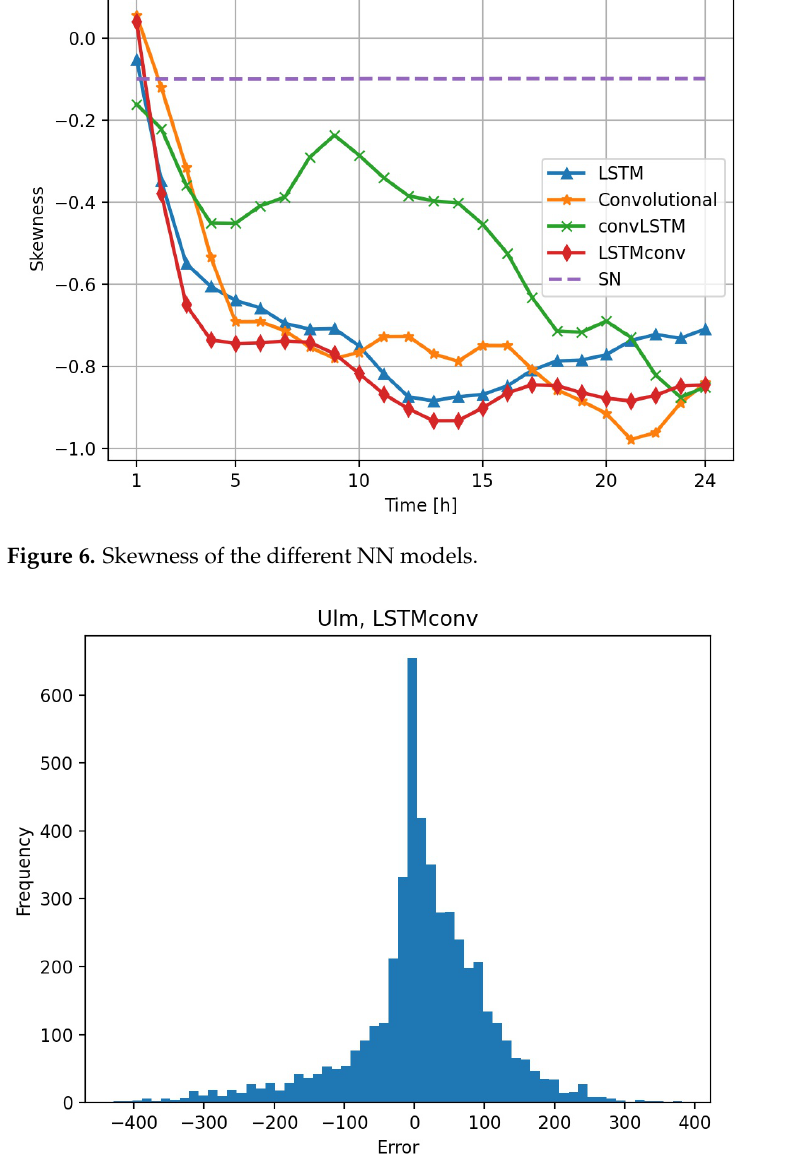
Figure 7. Histogram of the prediction errors for the LSTMconv model for six hour-ahead forecast in the city